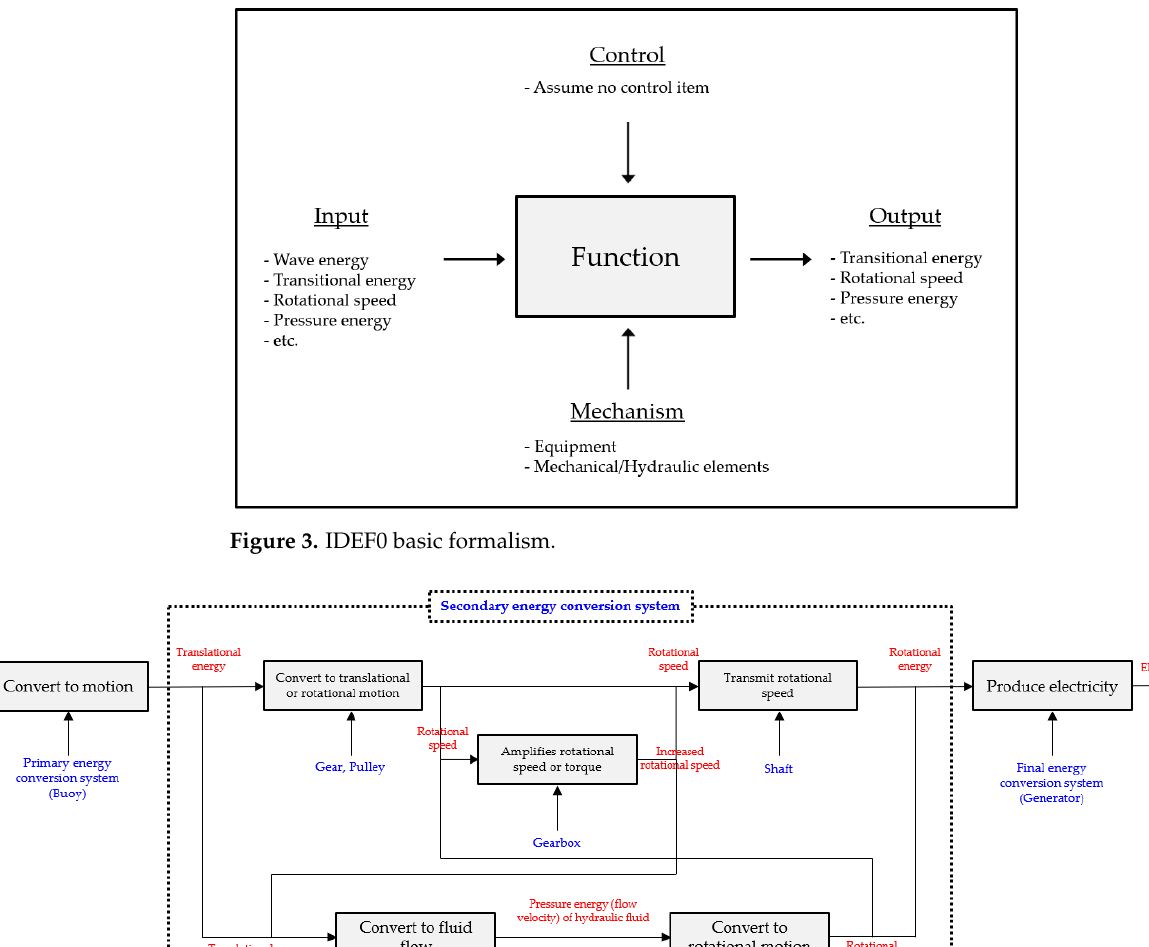
Figure 4. IDEF0 modeling of secondary energy conversion system.